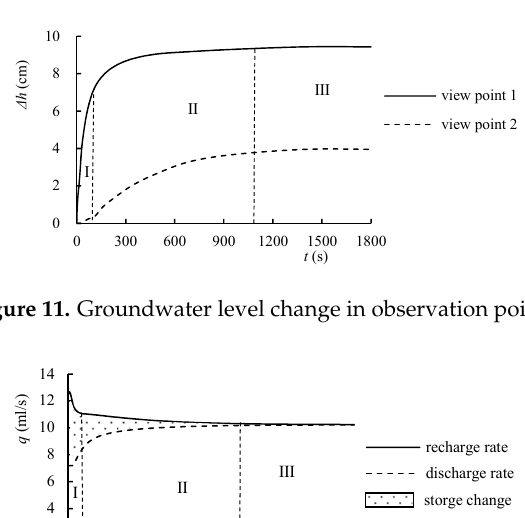
Table 3. Results of water budget.